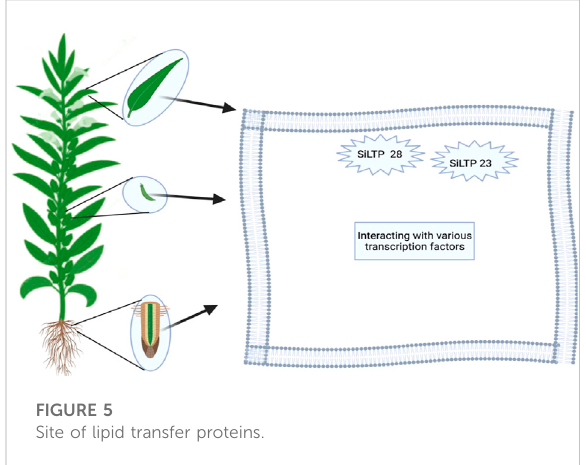
FIGURE 5 Site of lipid transfer